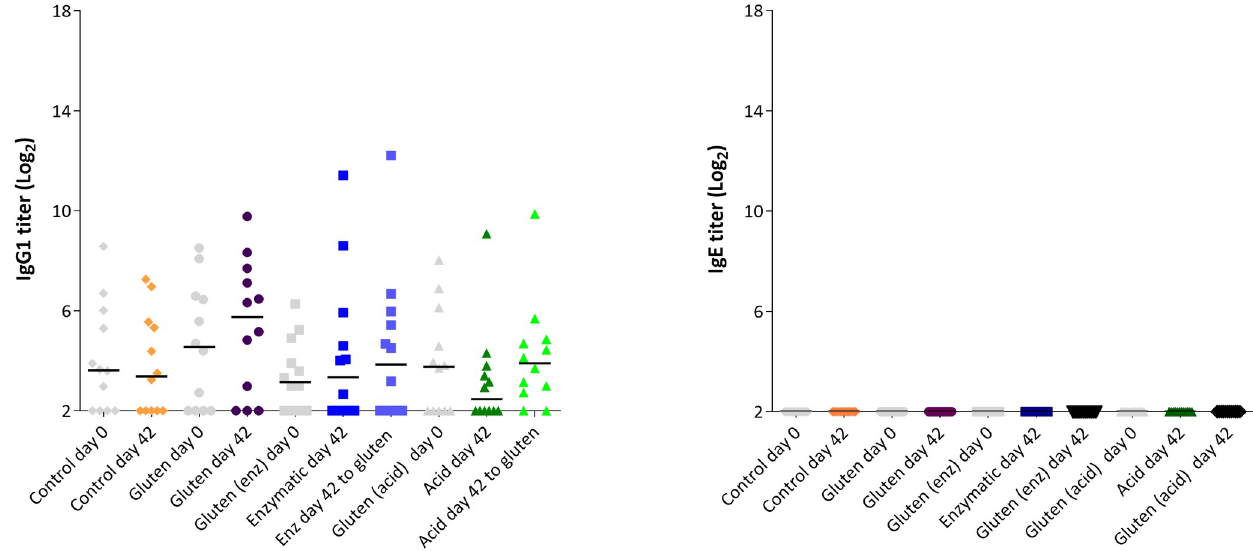
Fig 8. Specific antibody response to gluten at baseline, day 0 and 42, and to the respective antigens day 42 after oral dosing for 35 days with 20 mg gluten, enzymatic or acid hydrolyzed gluten. Results are shown as individual animals. There were no statistical differences between groups.